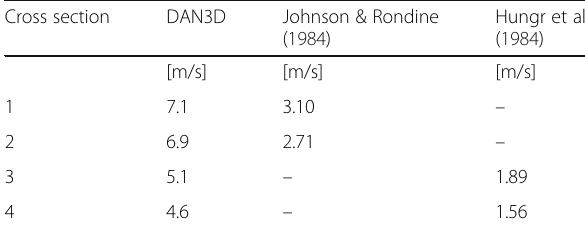
Table 5 Comparison between the DAN3D and empirical velocity values Cross